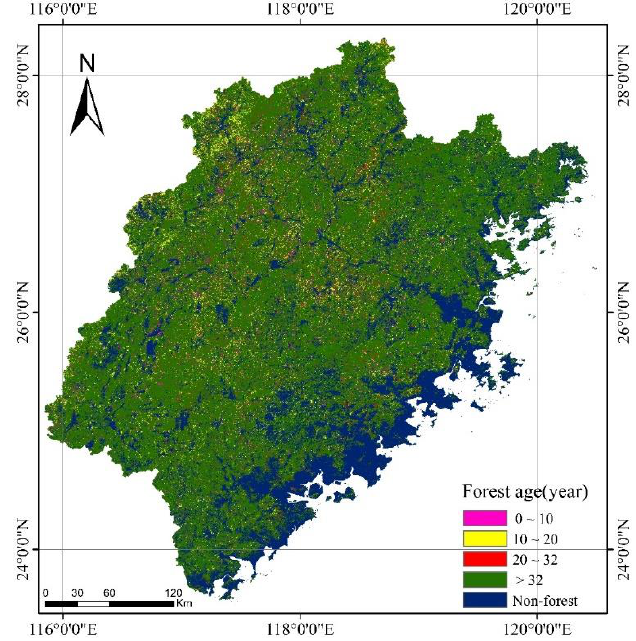
Figure 10. Forest age distribution map of Fujian in 2020.